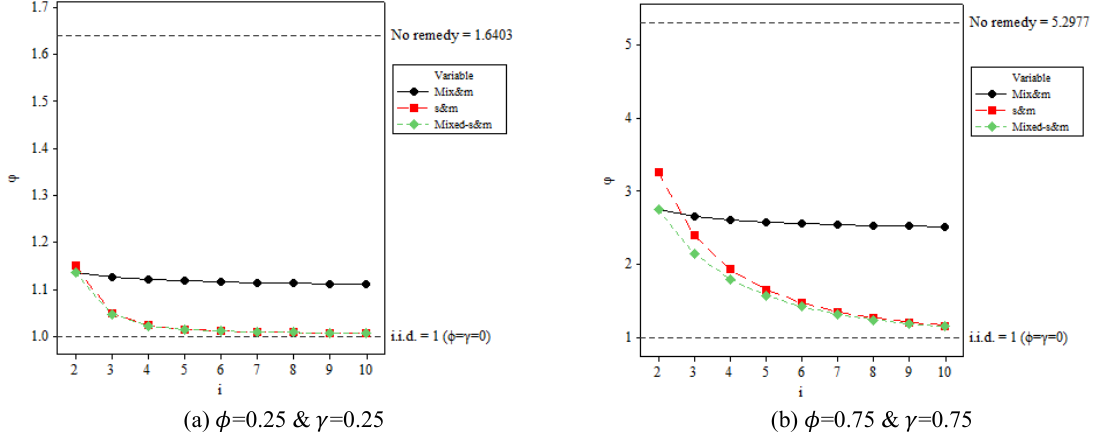
Fig. 6. The effect of different sampling strategies on 𝜑 when ( 𝜙 , 𝛾 ) ∈ {(0.25,0.25), (0.75,0.75)}, 𝑛 =10, 𝑖 ∈ {2,…,10} or ( s , m ) ∈ {(0,1), (1,2),…, (9,10)} For large values of 𝜙 and 𝛾 (e.g. 𝜙 = 𝛾 =0.75 in Fig. 6(b)), the values of 𝜑 for the s & m and mixed- s & m strategies only start getting close to a value of 1 at slightly higher values of s and m . The value of 𝜑 for the mix& m strategy is lower than the